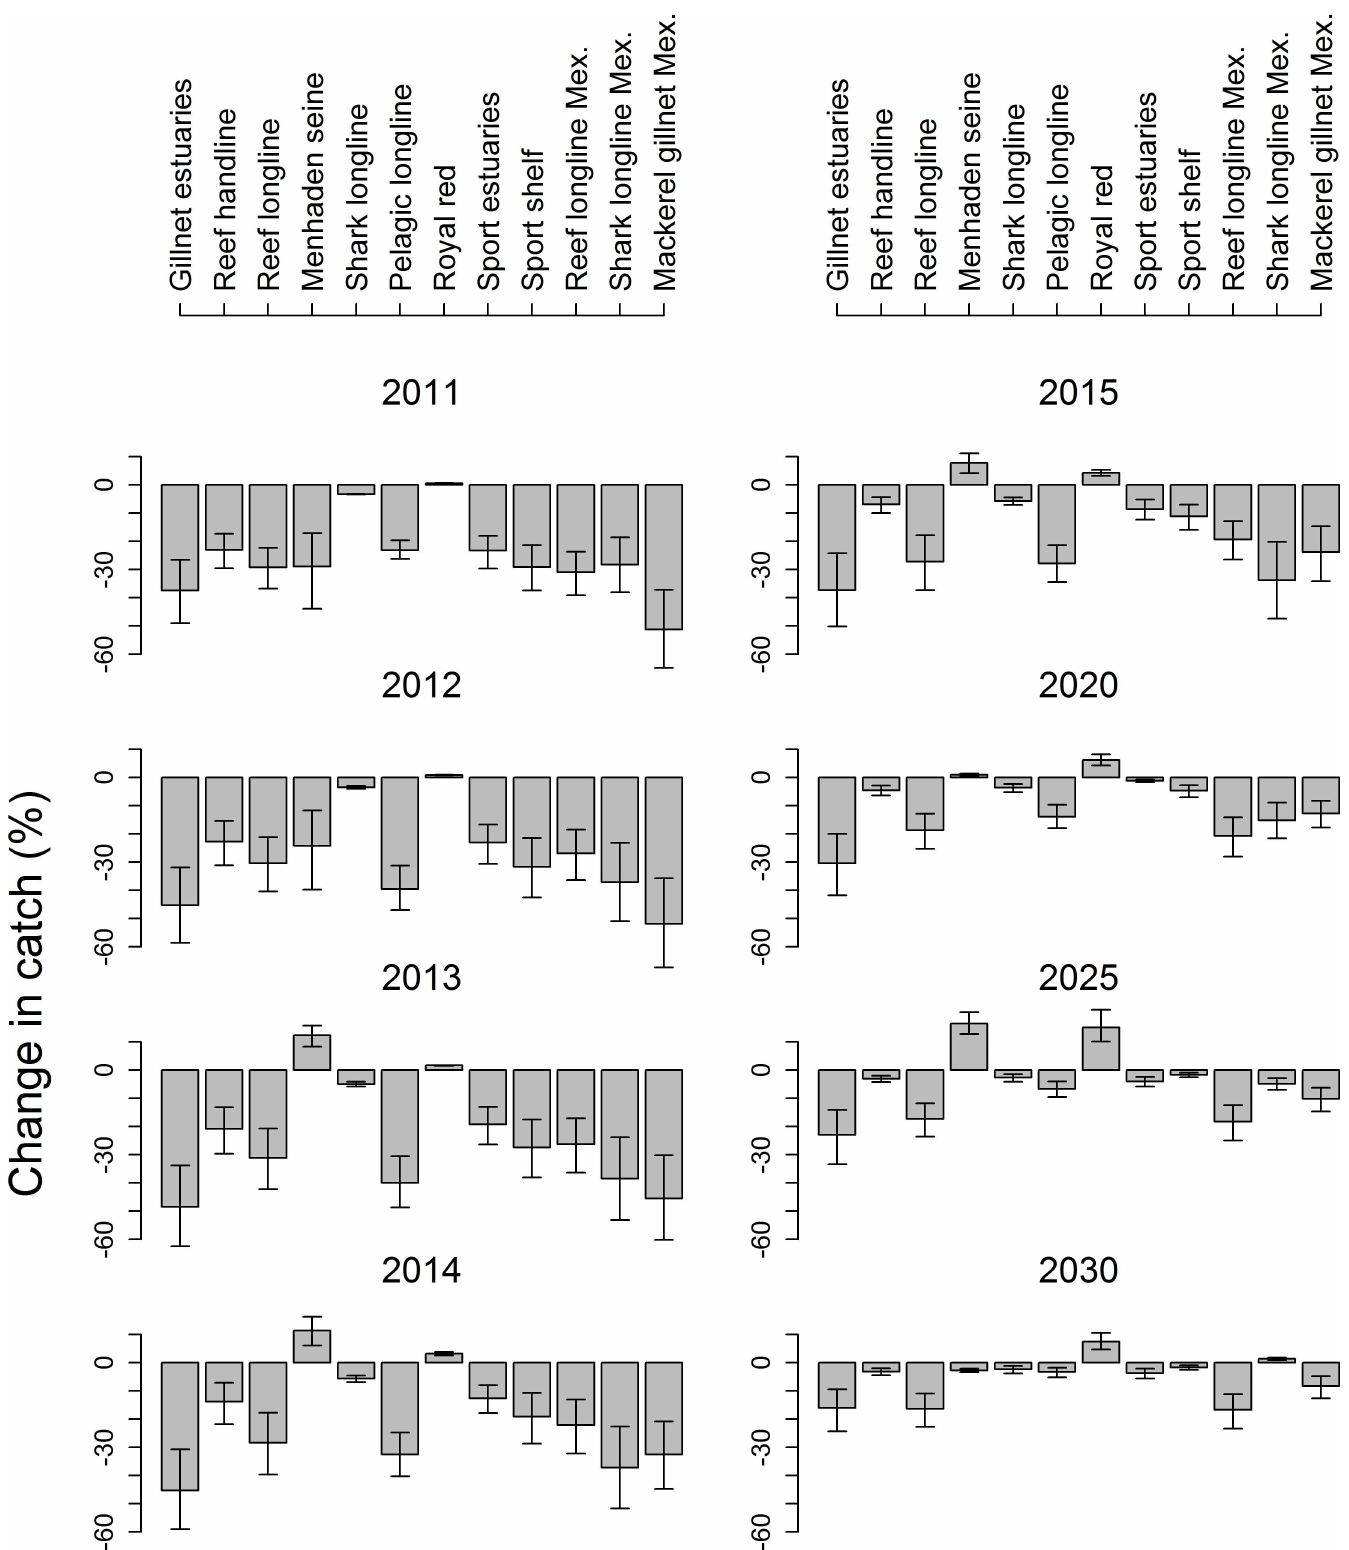
Fig 7. Projected annual catch for whole GOM. Catch presented relative to no-oil scenario. Error bars show range of sensitivity analysis; bars show mean.